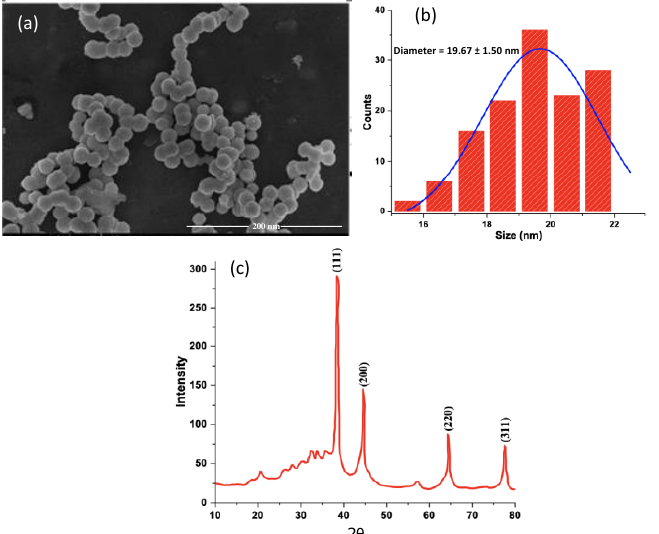
Figure 3. ( a ) SEM image of AgNPs@AA, ( b ) histogram for the size distribution of AgNPs@AA Figure 3. ( a) SEM image of AgNPs@AA, ( b ) histogram for the size distribution of AgNPs@AA esti- estimated from SEM image, and ( c ) XRD pattern of mated from SEM image, and ( c ) XRD pattern of AgNPs@AA.